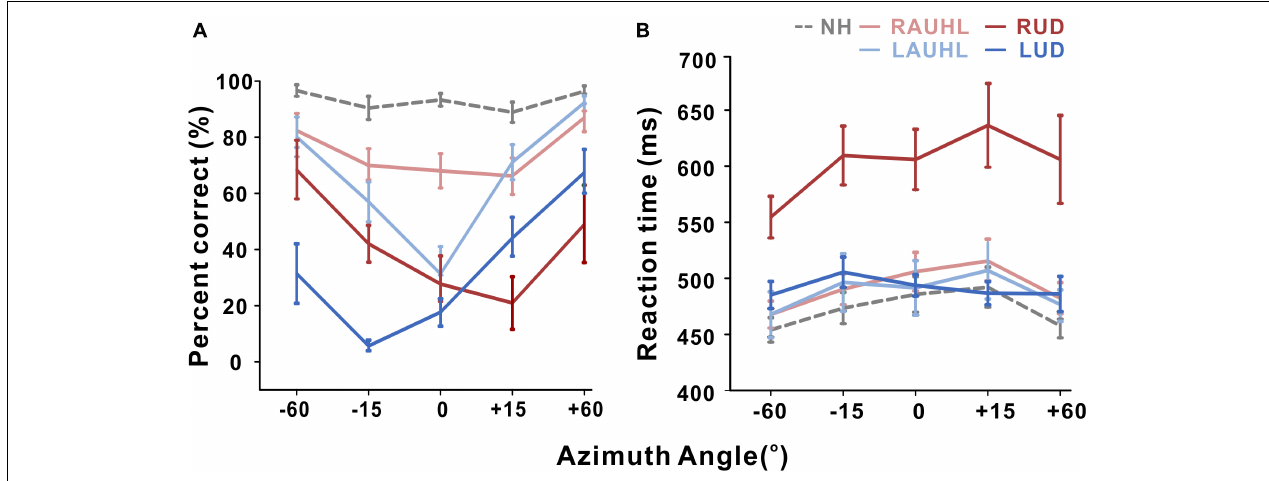
FIGURE 2 | Mean percent correct score (A) and reaction time (B) as a function of azimuth angle for the sound localization task during the active listening condition. Error bars: the standard error of the mean. RUD, right-sided unilaterally deaf; LUD, left-sided unilaterally deaf; RAUHL, right-sided acute unilateral hearing loss; LAUHL, left-sided acute unilateral hearing loss; NH, normal